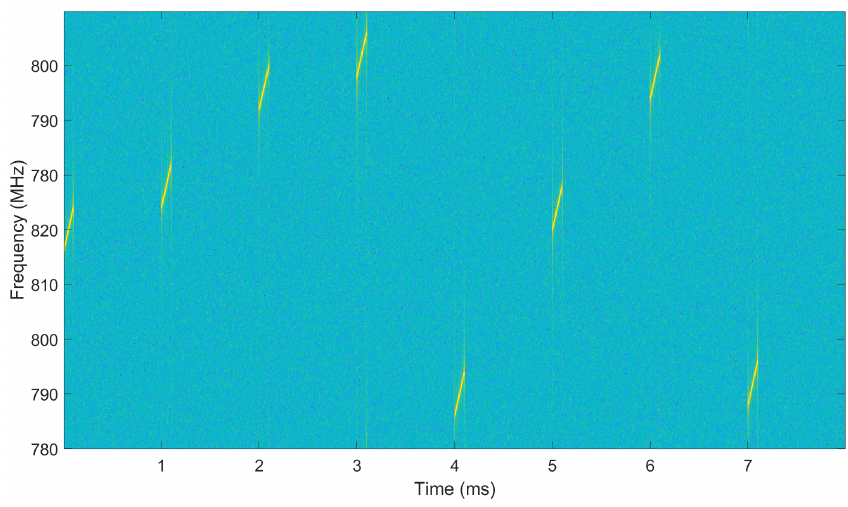
Figure 3. Spectrogram of transmitted signal.